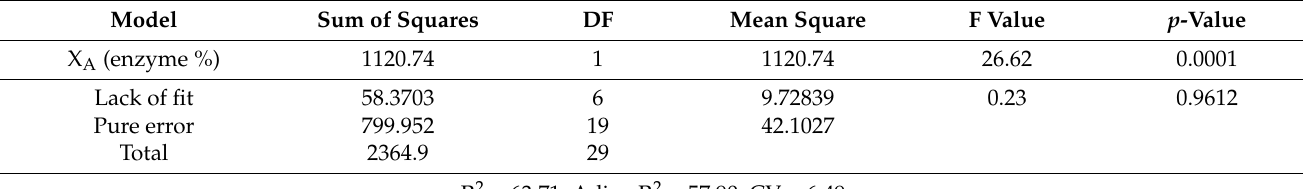
Table 10. Analysis of variance (ANOVA) for ACE inhibition (%) obtained for the corolase Box-Behken design.